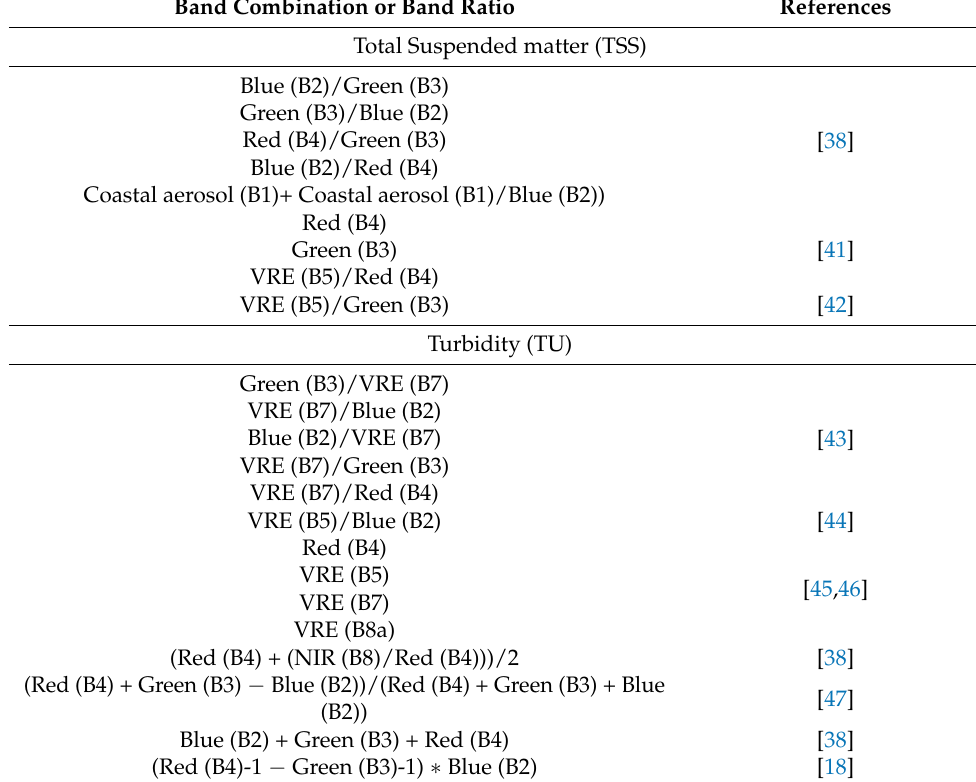
Table 1. Cont. Band Combination or Band